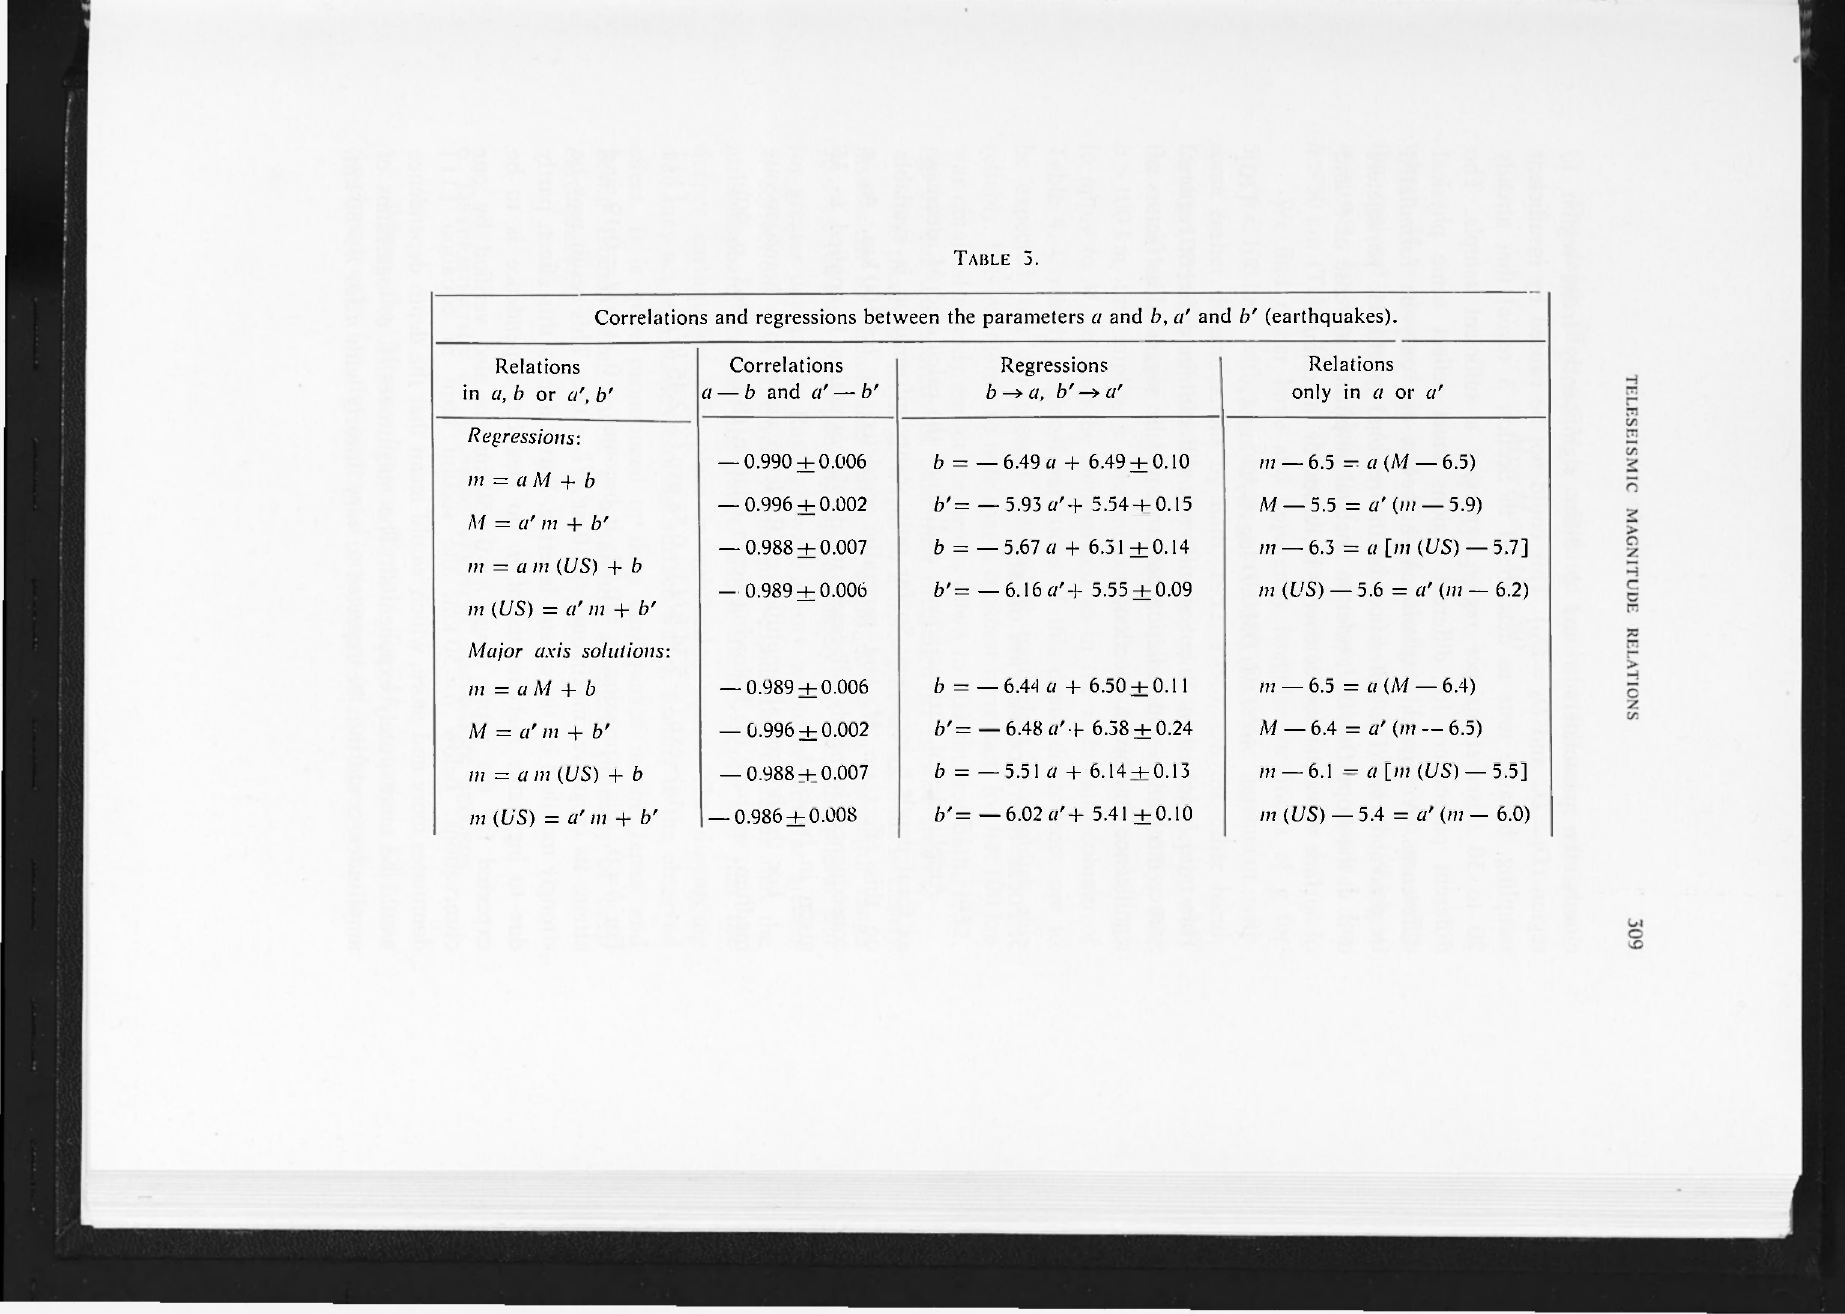
Correlations and regressions between the parameters a and b, a' and b'